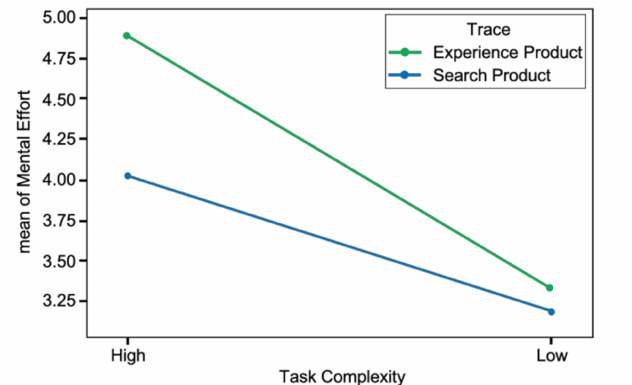
Figure 2. The effect of task complexity on perceived mental effort by product type.